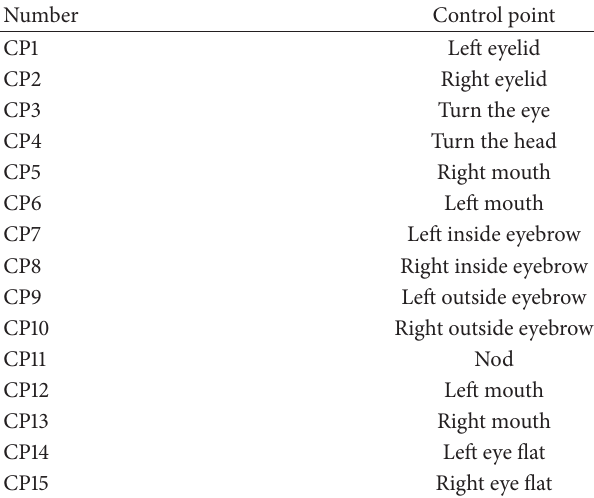
Table 3: Control points of robot head.